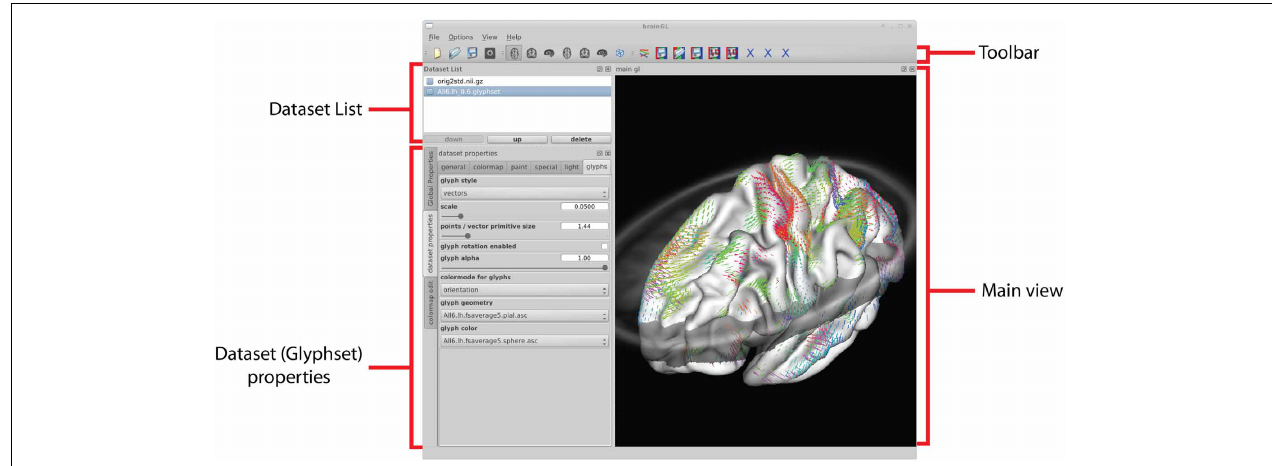
FIGURE 9 | The user interface is divided into a list of loaded datasets, three-dimensional views of the data, as well as global and dataset-specific properties. Depending on which data type is currently selected, different buttons in the toolbar are made available.